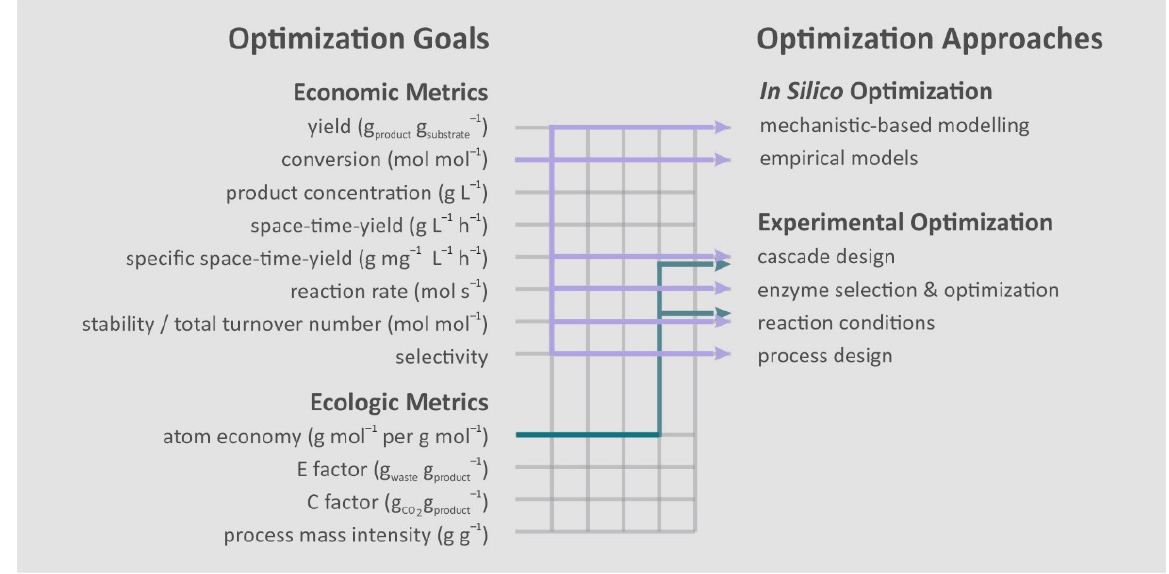
Figure 2. To reach optimization goals [8,32], many computational and experimental approaches are available. The correlations between them are complex and often a certain goal can be addressed by every approach presented here, while others are influenced by only a few. Two examples for these dependencies are highlighted in purple and green for the conversion and atom economy. E factor = environmental factor to calculate mass of waste per mass of product, C factor = cover-management factor to calculate soil